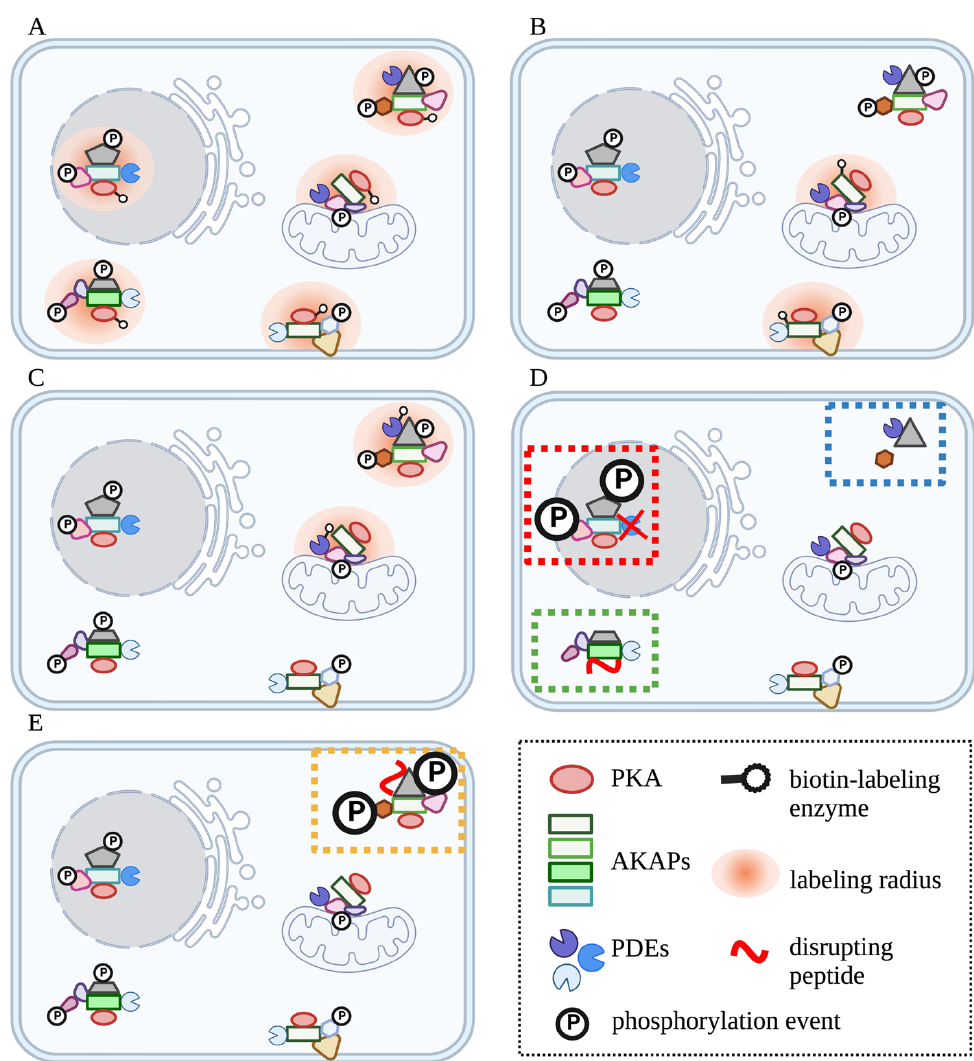
Figure 6. A multi-angular proteomics view on compartmentalized cAMP signaling. Illustration of ( A ) PKA-centric, ( B ) AKAP-centric, and ( C ) PDE-centric PL-MS strategies. For domain components-